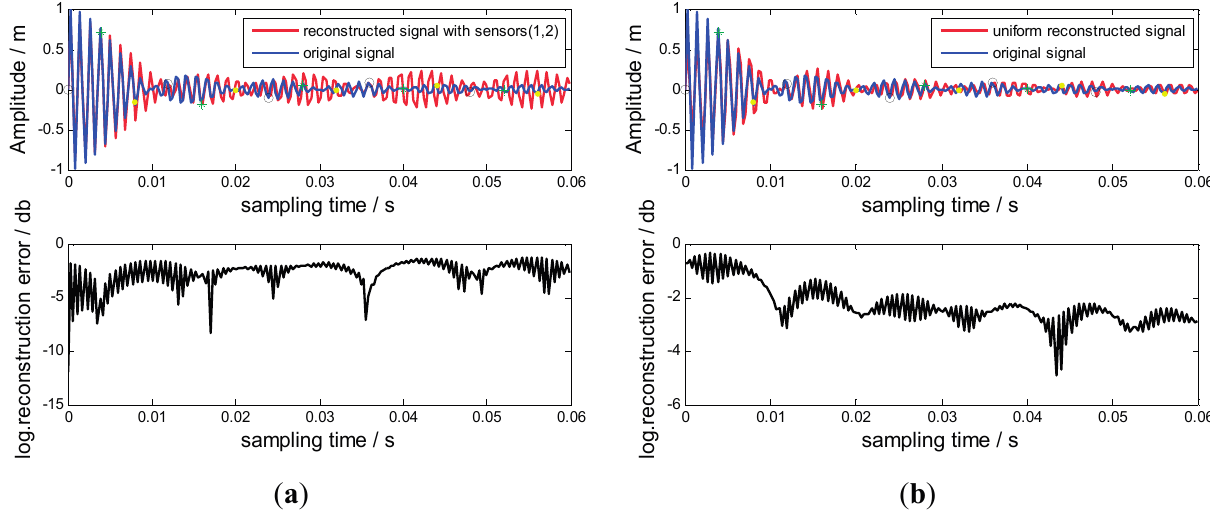
Figure 9. Reconstructed signals and the original signal with B 0 = 100 Hz for ( a ) the non-uniform sampling and ( b ) the uniform